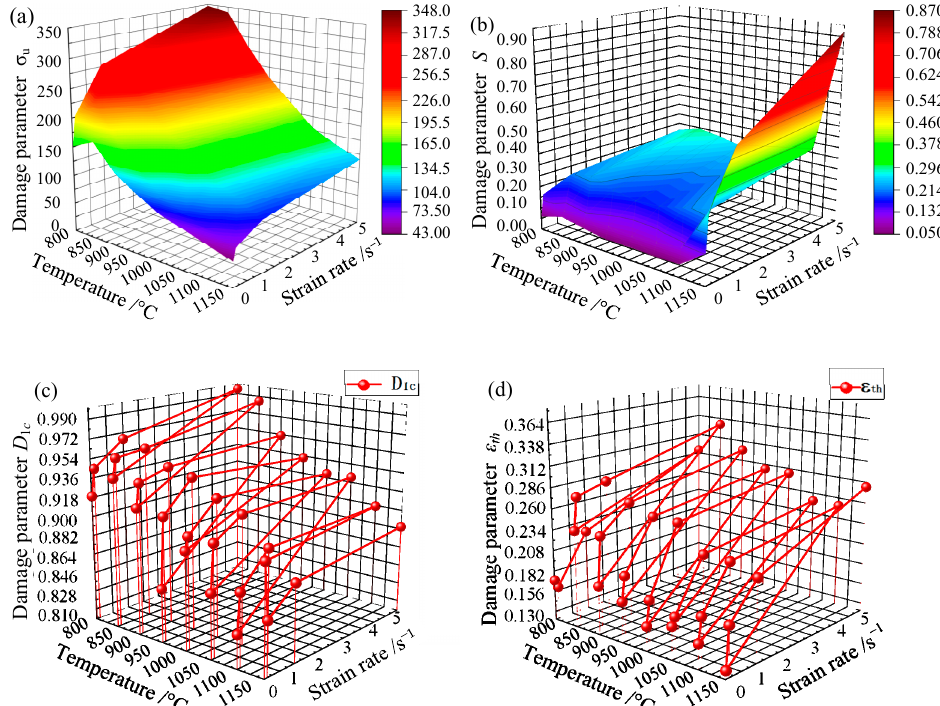
Figure 12. Damage diagram of Lemaitre damage parameters of Cr5 alloy steel: ( a ) surface diagram based on ultimate stress σ u with temperature and strain rate; ( b ) surface diagram based on anti-damage factor S with temperature and strain rate; ( c ) surface diagram based on critical damage value D 1 c with temperature and strain rate; and ( d ) surface diagram based on damage strain threshold ε th with temperature and strain rate.